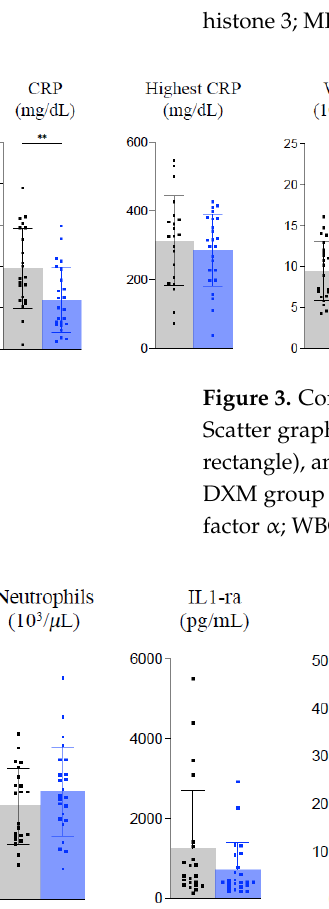
Figure 4. Corticosteroid effects on myeloid immune response in critical COVID-19 patients. Scatter graphs of myeloid inflammatory cytokines. Individual values (dots), mean (colored rectangle), and standard deviation are presented on the graphs. ** p < 0.01 between the no DXM group and the DXM group. IL, interleukin; IL-1ra, IL-1 receptor antagonist; MCP-1, monocyte chemoattractant protein 1; MIP, macrophage inflammatory protein-1 α ; sTREM-1, soluble triggering receptor expressed on myeloid cells 1.